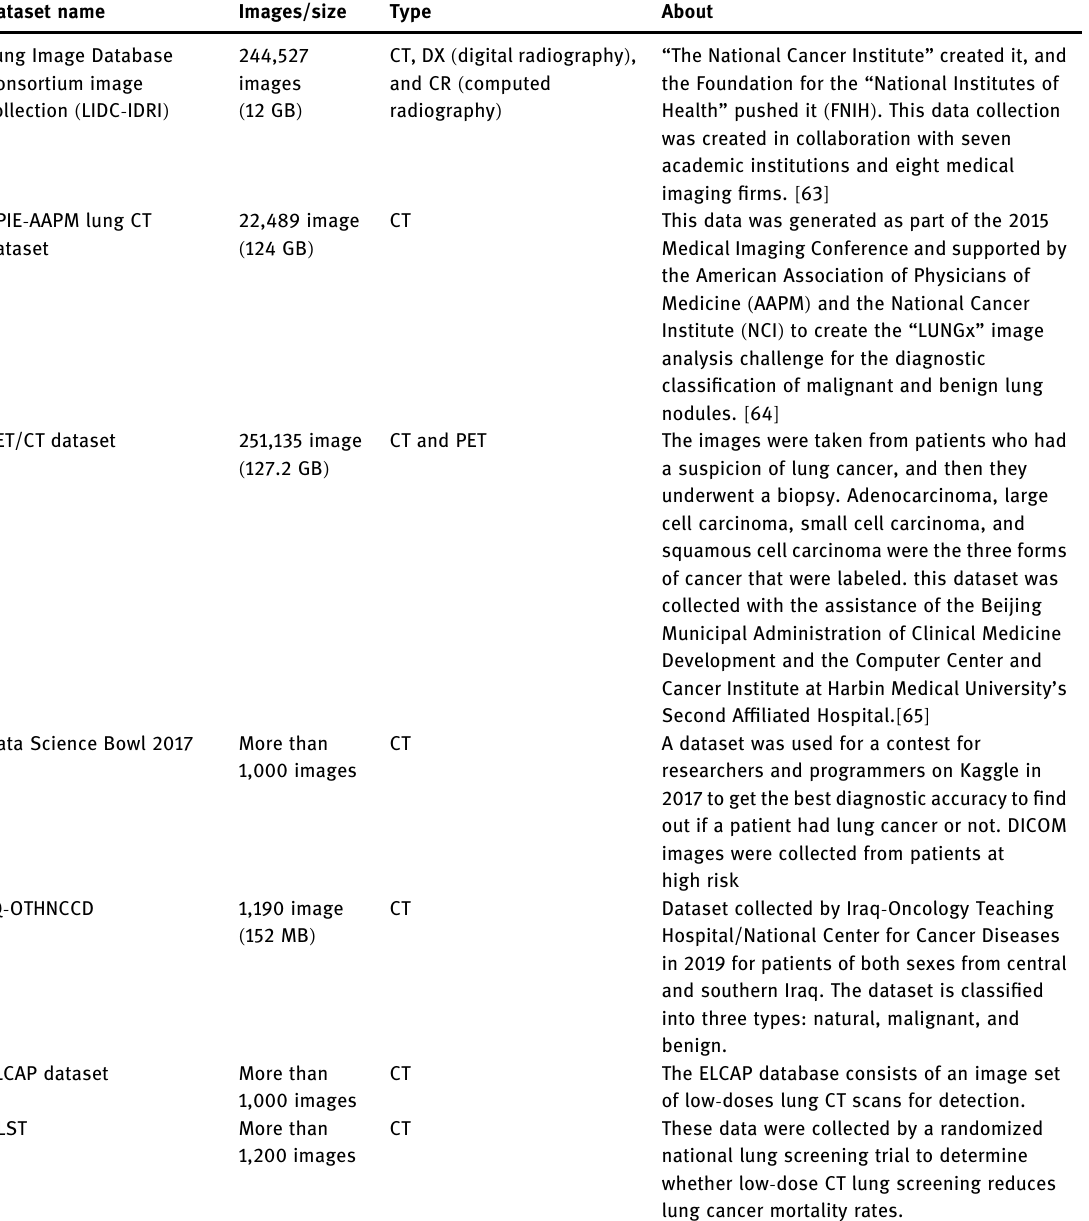
Table 3: Explanation datasets used in